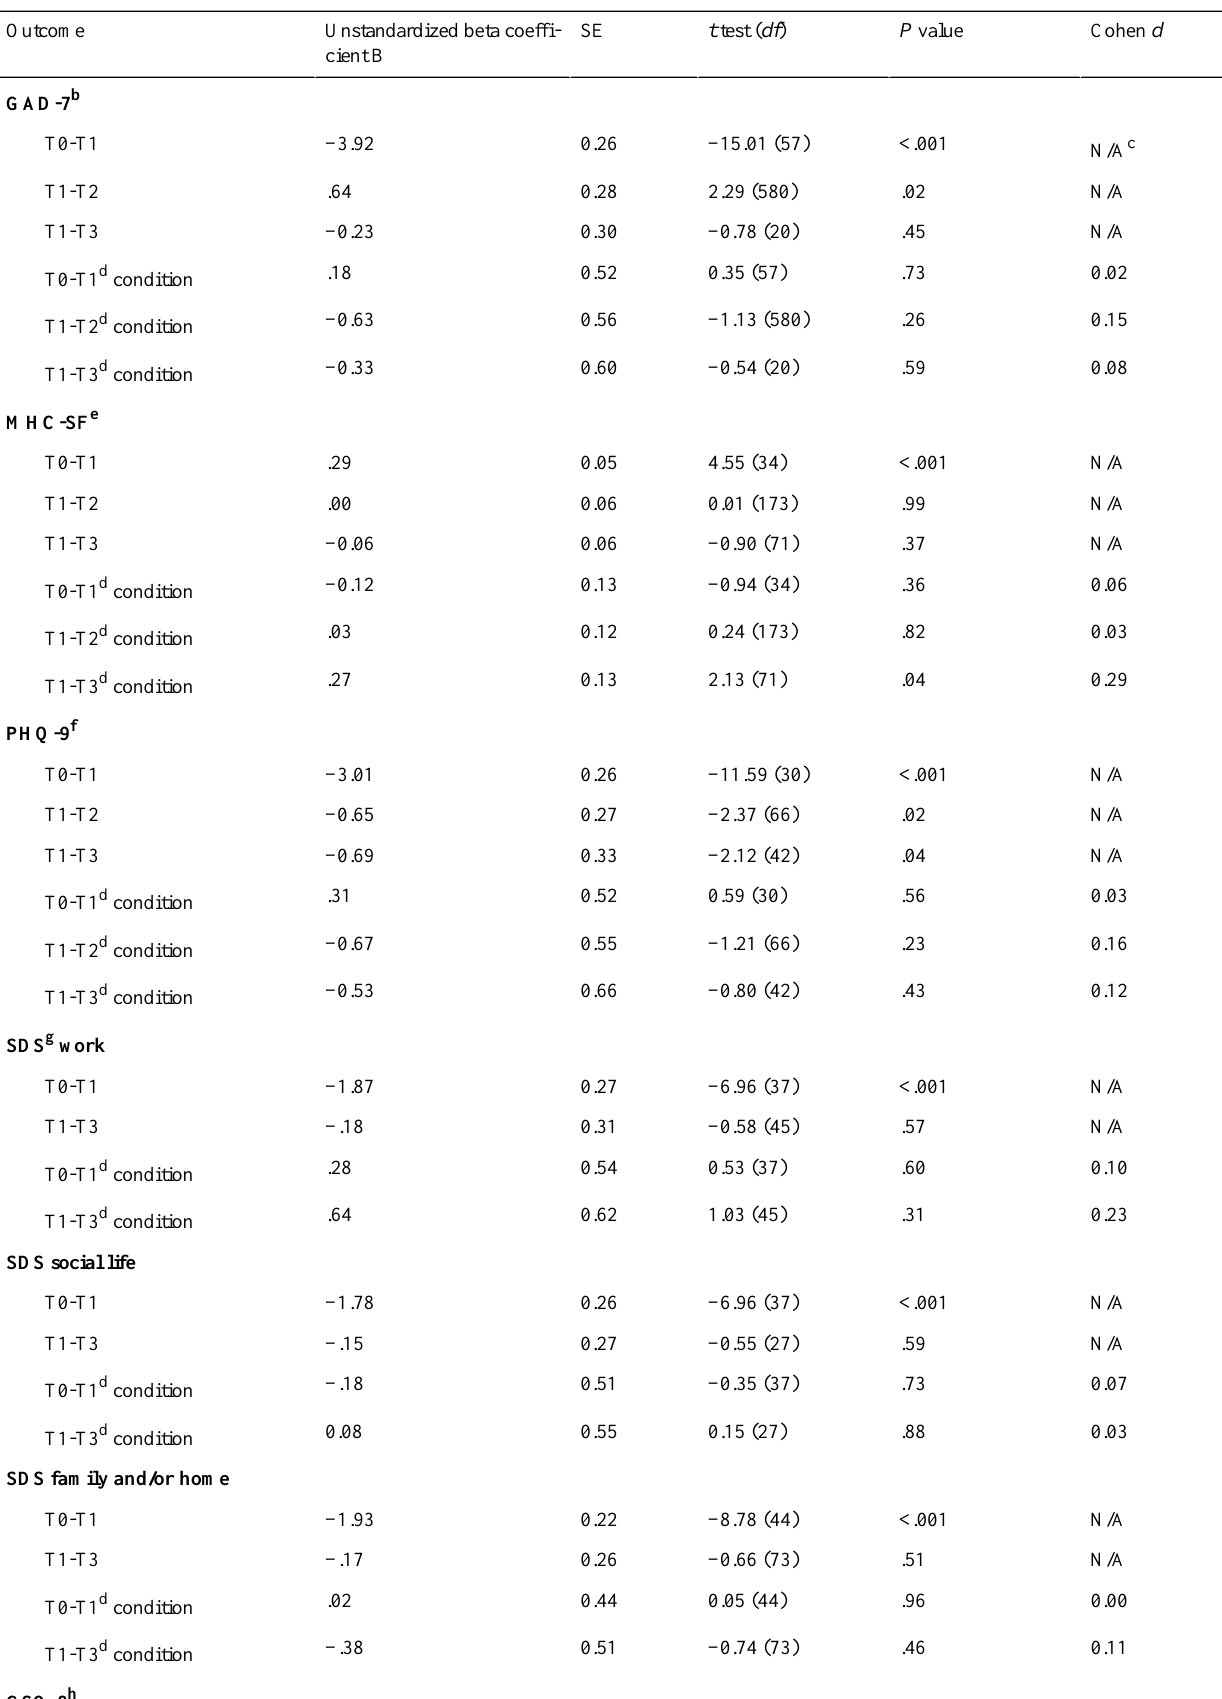
Table 3. Mixed model analyses comparing the differences between the blended acceptance and commitment therapy and cognitive behavioral therapy group over time and between-group effect